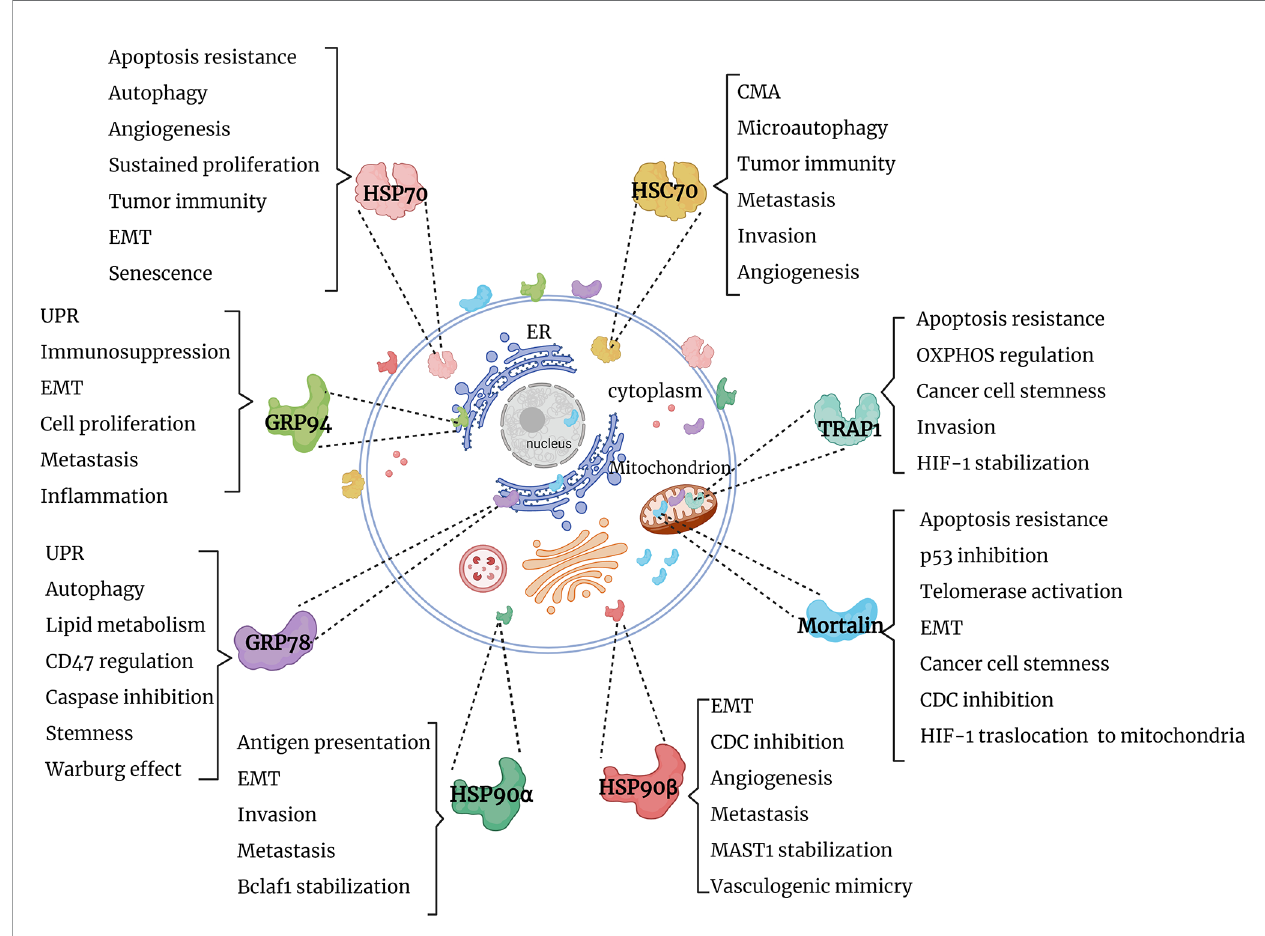
FIGURE 1 | Graphical summary of HSP90 and HSP70 functions in cancer. HSP90 and HSP70 homologs are distributed in cytosol, nucleus, ER and mitochondria, where they perform speci fi c functions, supporting tumor survival and growth. EMT, epithelial-mesenchymal transition; UPR, unfolded protein response; OXPHOS, oxidative phosphorylation; CMA, chaperone-mediated autophagy; CDC, complement-dependent cytotoxicity; Bclaf1, B-cell lymphoma 2 -associated transcription factor 1; HIF-1, hypoxia-inducible factor 1; MAST1, microtubule-associated serine/threonine kinase